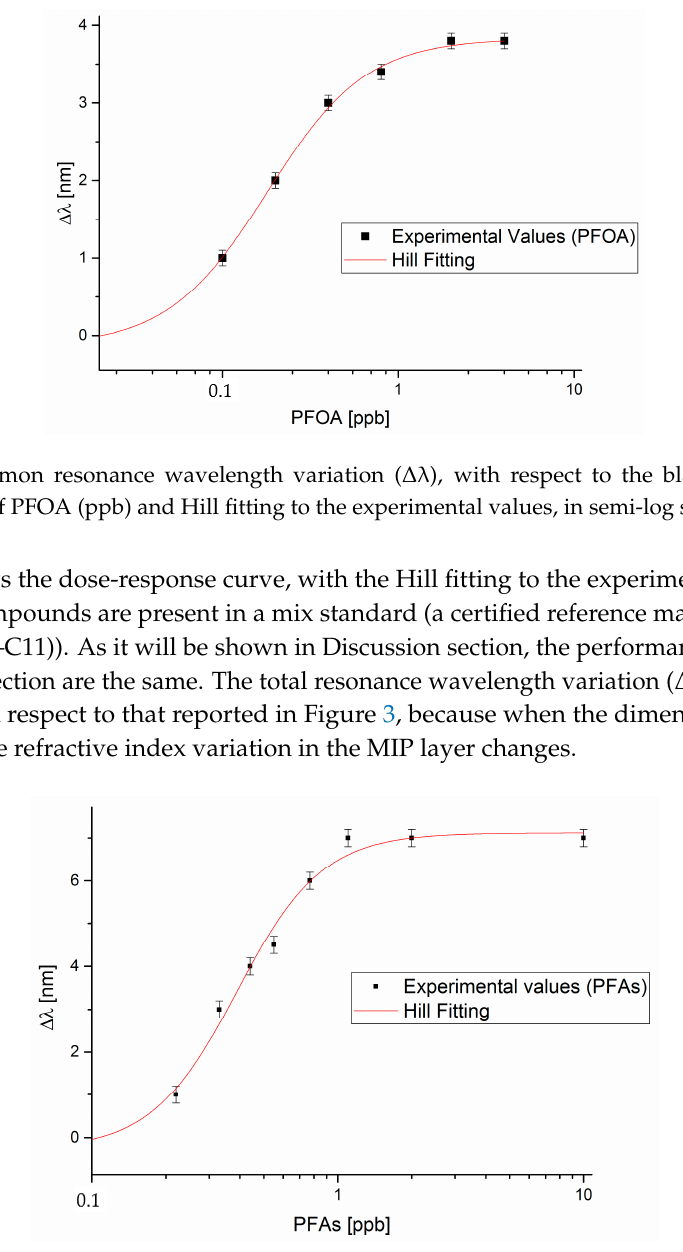
Figure 4. Plasmon resonance wavelength variation ( ∆λ ), with respect to the blank, versus the concentration of PFAs (ppb) and Hill fitting to the experimental values, in semi-log scale.